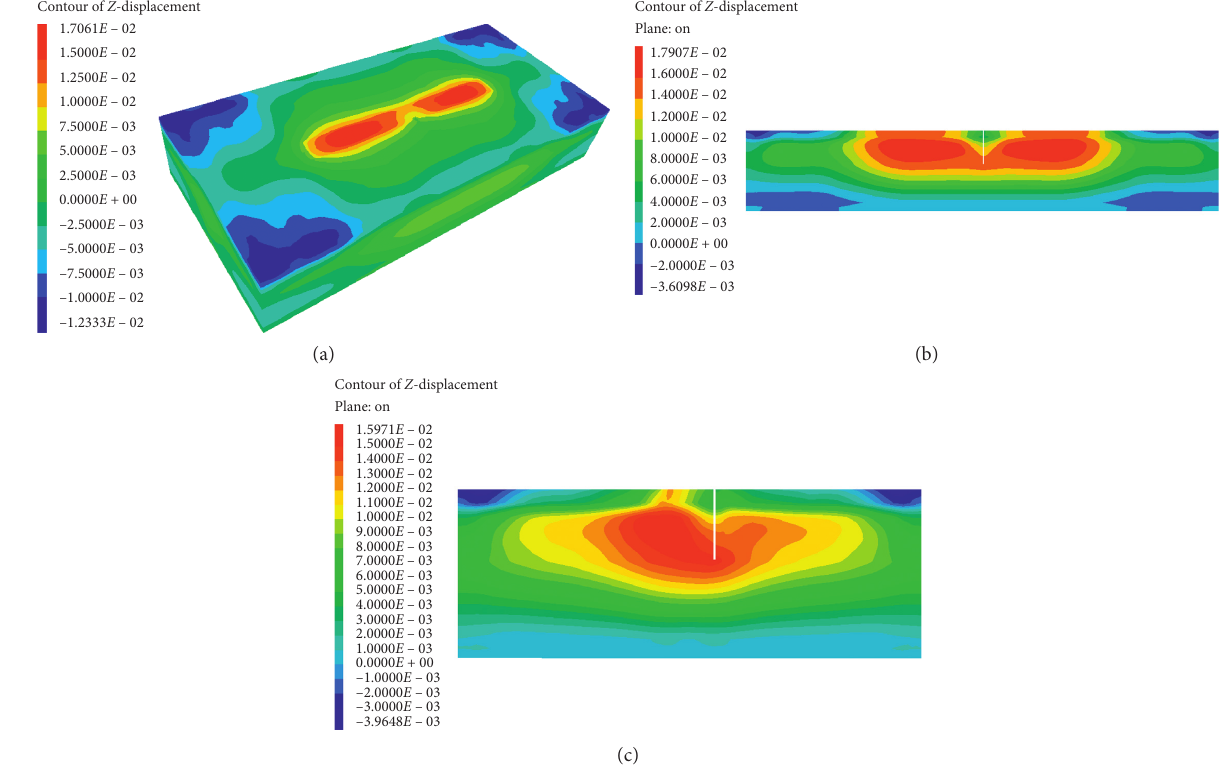
Figure 22: Single well subsidence nephogram when the drawdown is stable (unit: m). (a) Three-dimensional diagram. (b) Cross section of the well midpoint. (c) Longitudinal section of the well midpoint.